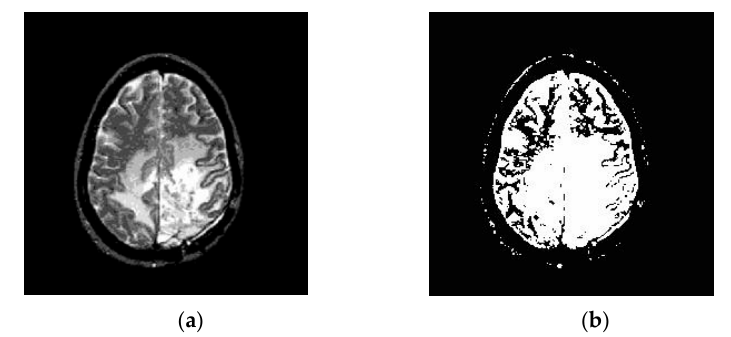
Figure 5. ( a ) Image after Otsu threshold, ( b ) Image after fuzzy c-means cluster.